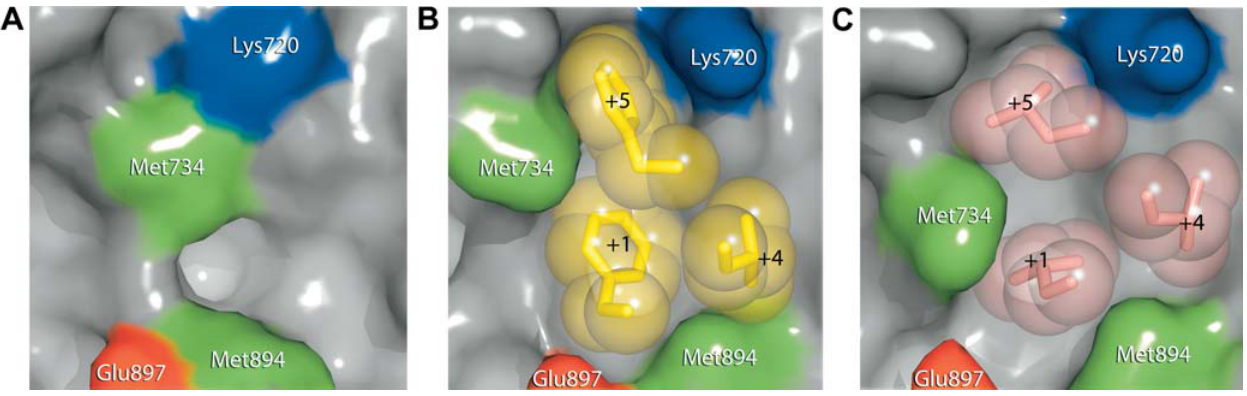
Figure 4. Induced Fit of the AR AF-2 Interface Surface representations of the AR AF-2 interface. The unbound structure is shown in (A), the FxxLF bound in (B), and the LxxLL bound in (C). Side chains of the hydrophobic residues of the core motifs of FxxLF and LxxLL are shown as spheres. DOI: